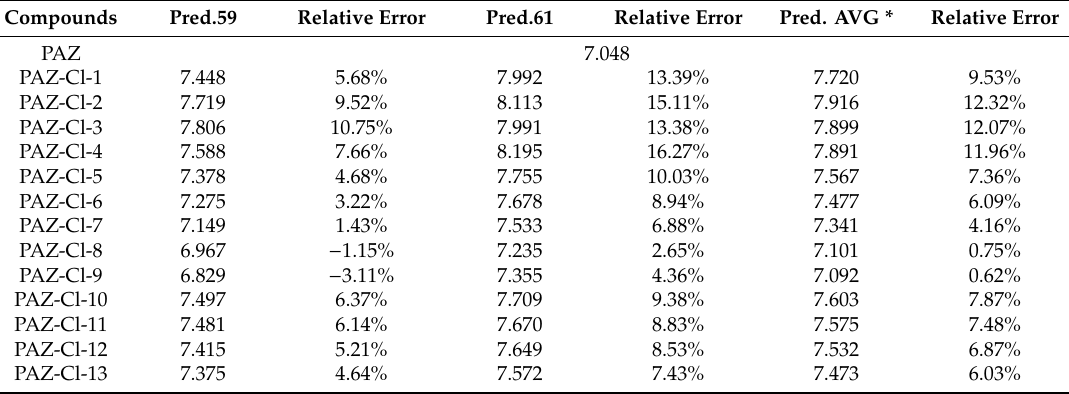
Table 9. Risk assessment of genotoxicity of disinfection by-products of